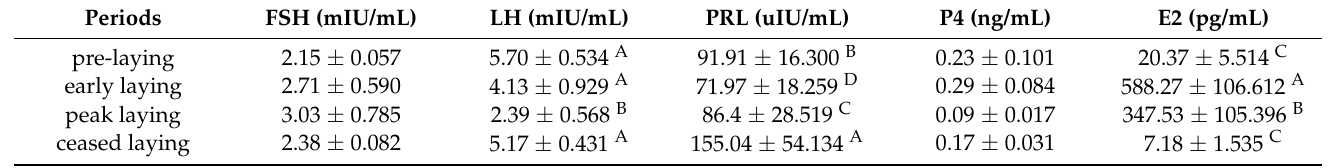
Table 2. Reproductive hormone concentration in Wanxi White goose at different laying